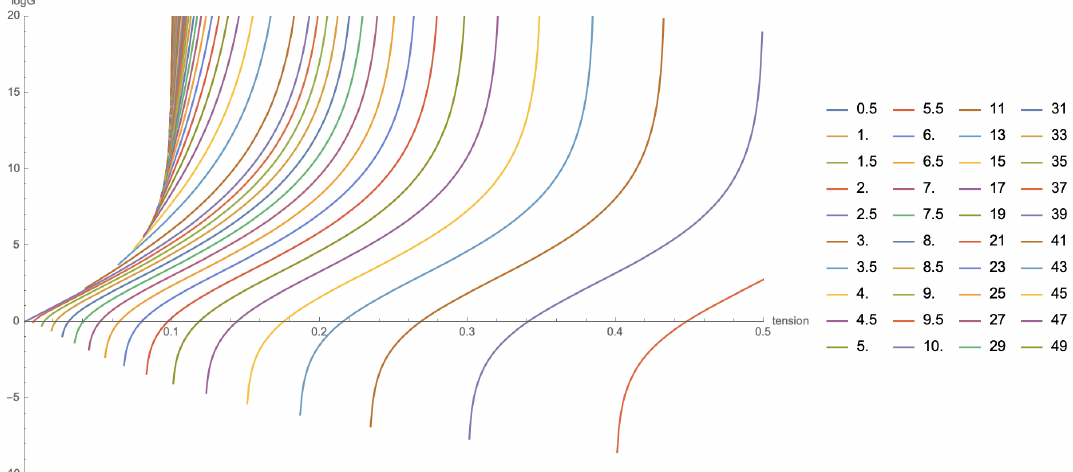
Figure 5 . The additional entanglement entropy ( log g ) for the 3-region holographic model, where we consider a symmetric fusion of defects with l L = l R = 10 , τ 1 = τ 2 . Legend shows l C values. Moving left to right, the curves are given by decreasing l C values.